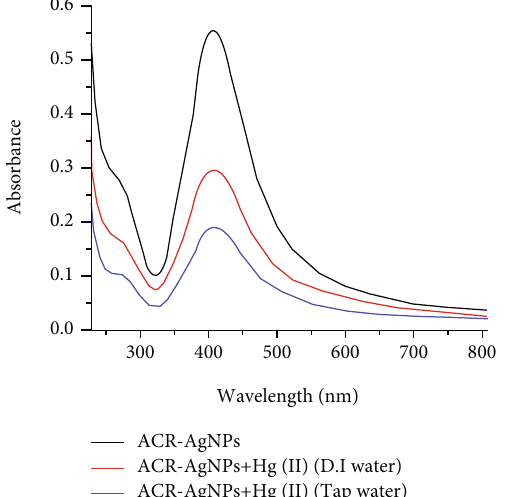
Figure 13: Application of ACR-AgNPs for the detection of Hg 2+ in water sample.